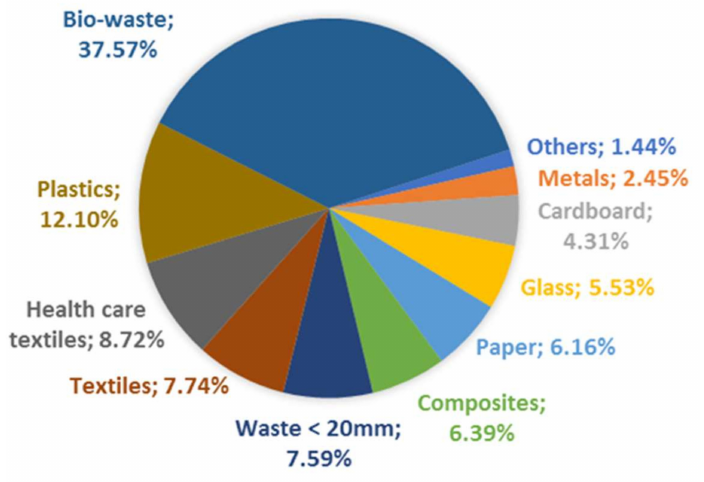
Figure 2. Global municipal solid waste characterization for the sample used in this